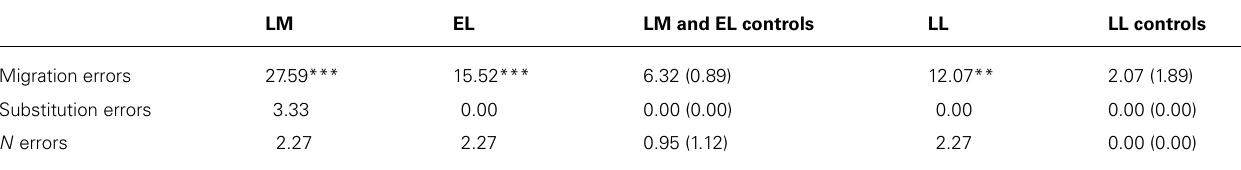
Table 2 | Percentage of errors on reading aloud words in the migration and substitution conditions. LM EL LM and EL controls LL LL